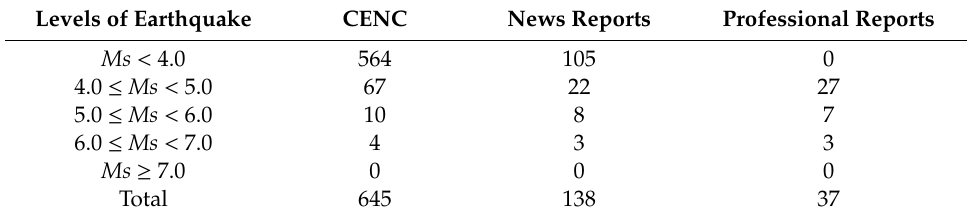
Table 8. Classification statistics of earthquakes in Xinjiang province.